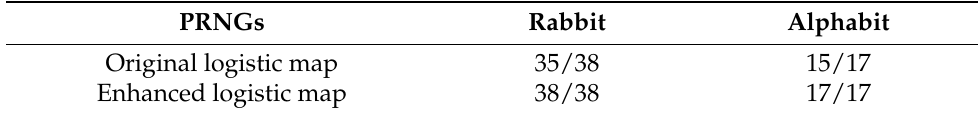
Table 3. Results of the TestU01 test for different